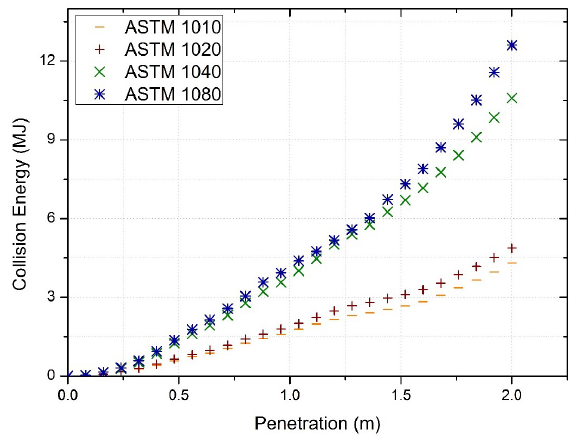
Figure 7: Energy characteristic for all proposed material types.